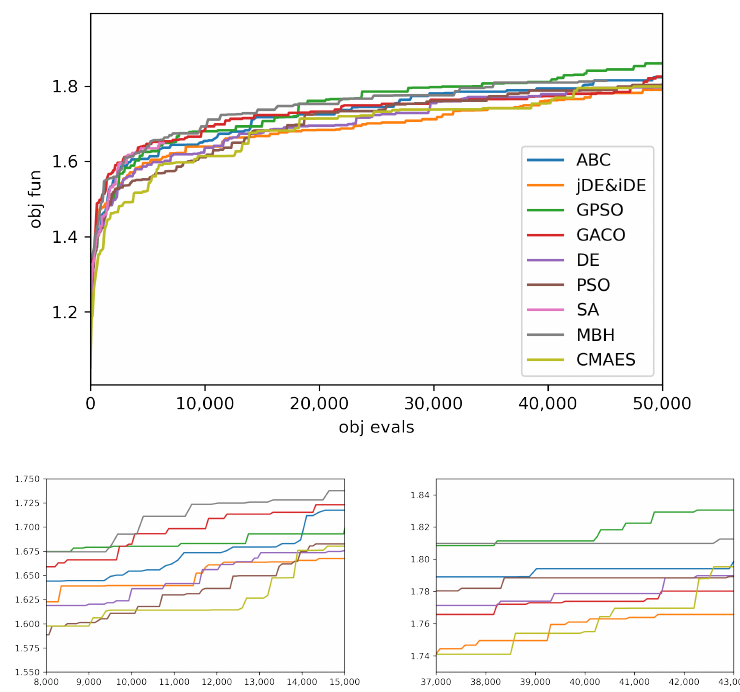
Figure 4. Average rate during fitness evaluation ( N =